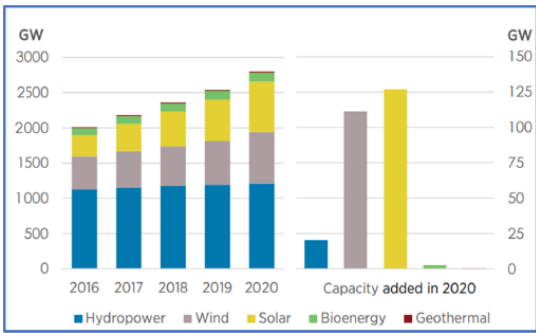
Figure 1. Global renewable energy transition [4].